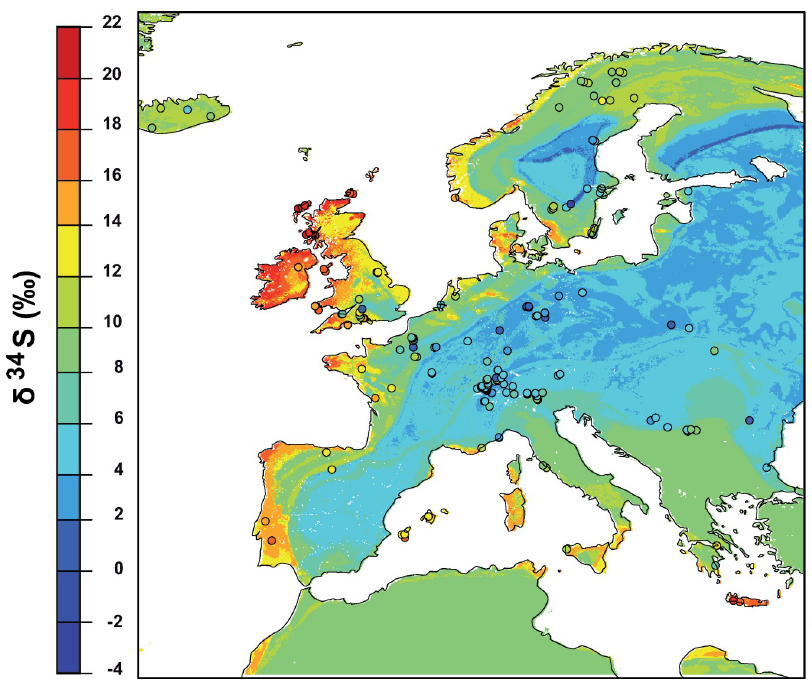
Fig 2. Sulfur isoscape of human remains across Europe. Spatial distribution of the sulfur isotope composition ( δ 34 S) across Europe from a compilation of animal and human teeth from post-Mesolithic times (S1 Dataset) and isoscape developed in this